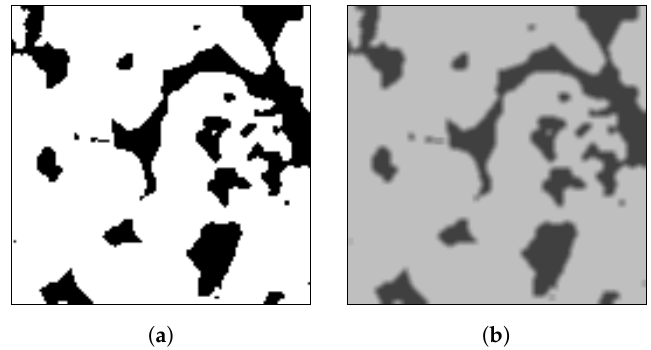
Figure 4. Illustration of preprocessing for input images: without preprocessing the binarized input images, the glow models do not converge during training. ( a ) Original binary image patch; ( b )grayscale preprocessed image patch.